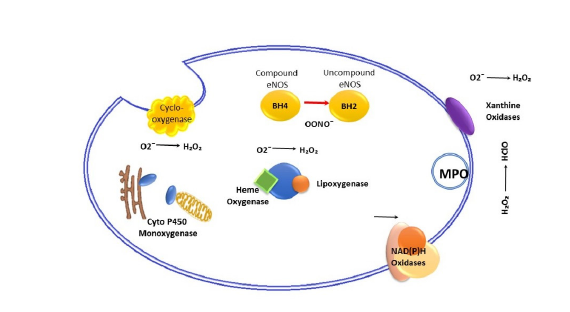
Figure 1. Potential Sources of ROS.